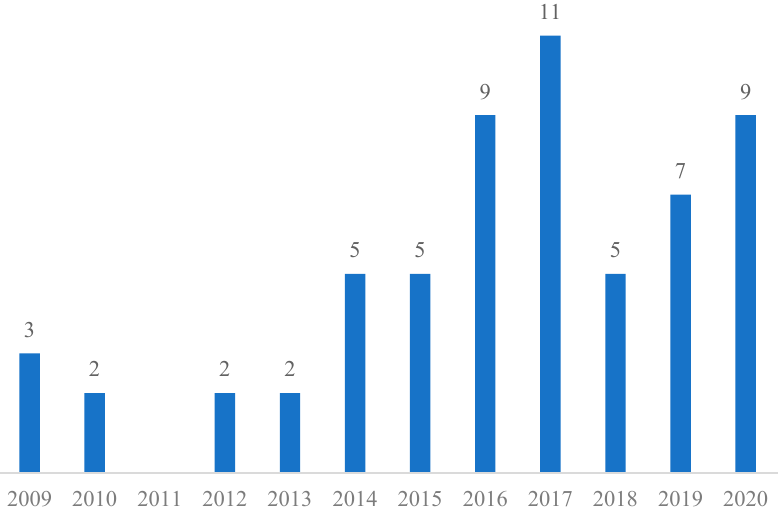
Figure 2. Annual numbers of systematic review publications. Source: Authors’ own multi-database literature search.